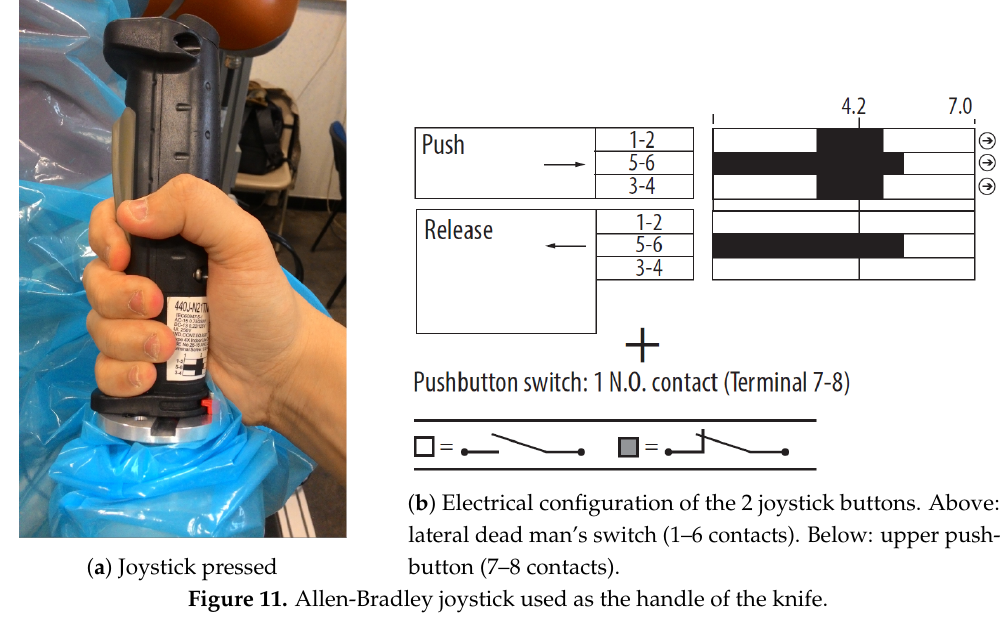
Figure 11. Allen-Bradley joystick used as the handle of the knife.